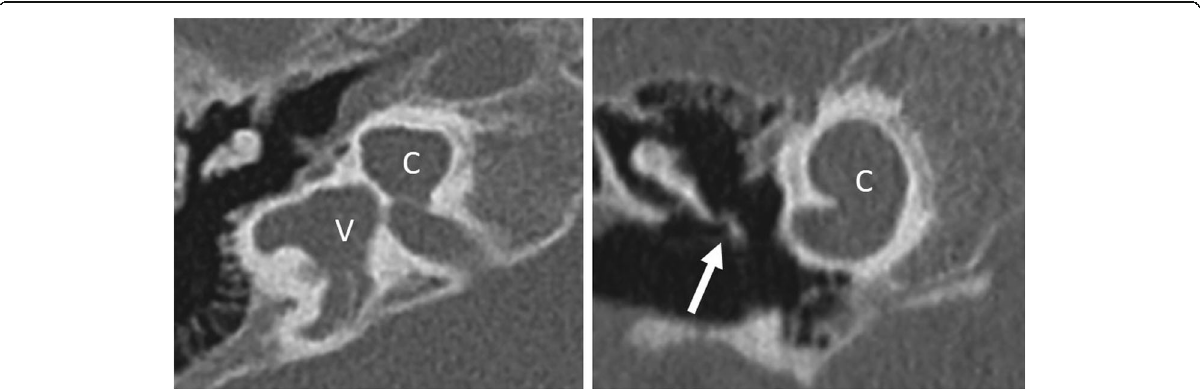
Fig. 8 A 1-year-old male patient, with sensorineural deafness from birth. HRCT axial image (left) and coronal image (right) show incomplete partition type I, with empty cystic cochlea (C) and a large dilated vestibulum (V). Stapes is malformed and fused with the incus (arrow)